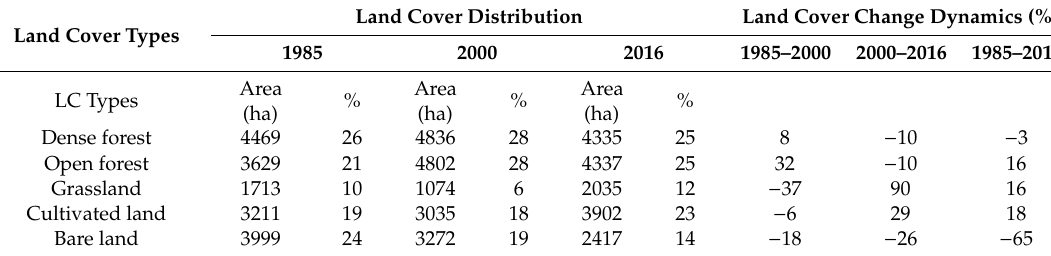
Table 1. Area and proportion of land cover change in Wujig Mahgo Waren forest in 1985, 2000, and 2016.